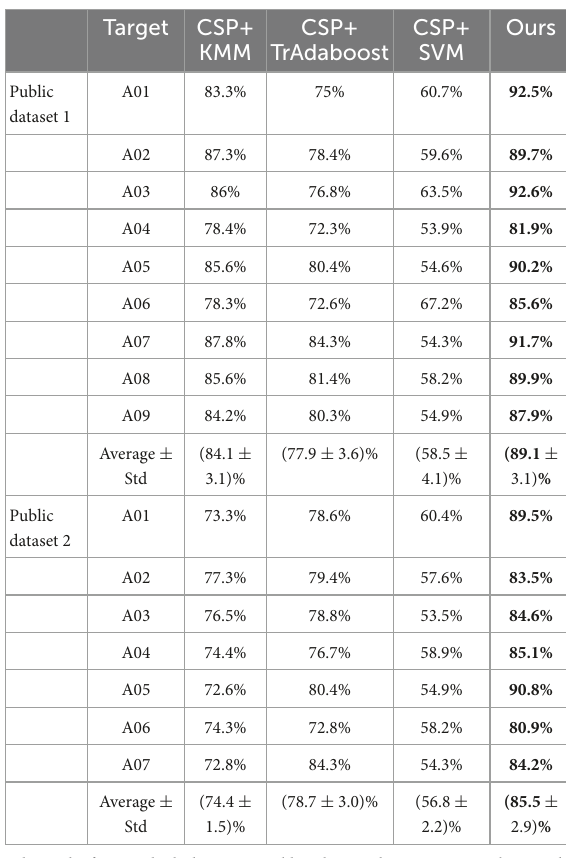
TABLE 2 Comparison of the accuracies (%) between the proposed algorithm and other methods on the public dataset 1 and public dataset